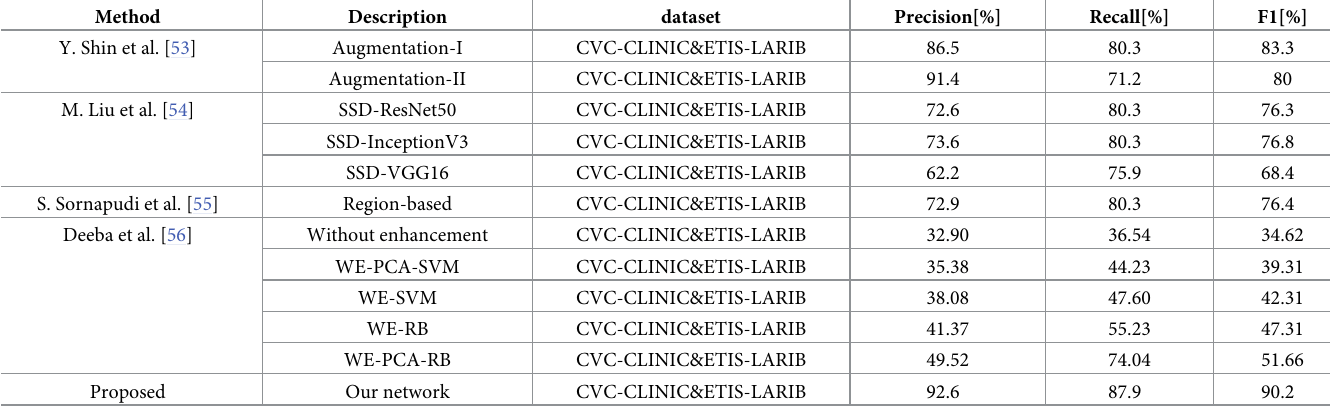
Table 5. Comparison of performance for colonic polyps